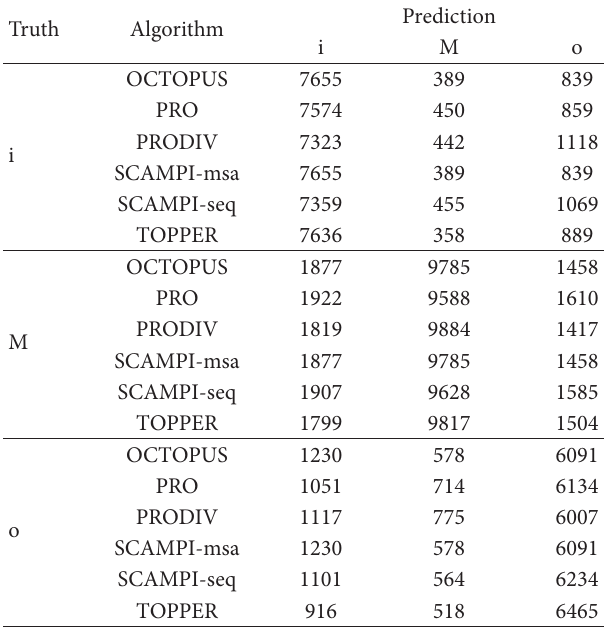
T 1: Confusion matrices of residue prediction for various algorithms. Truth